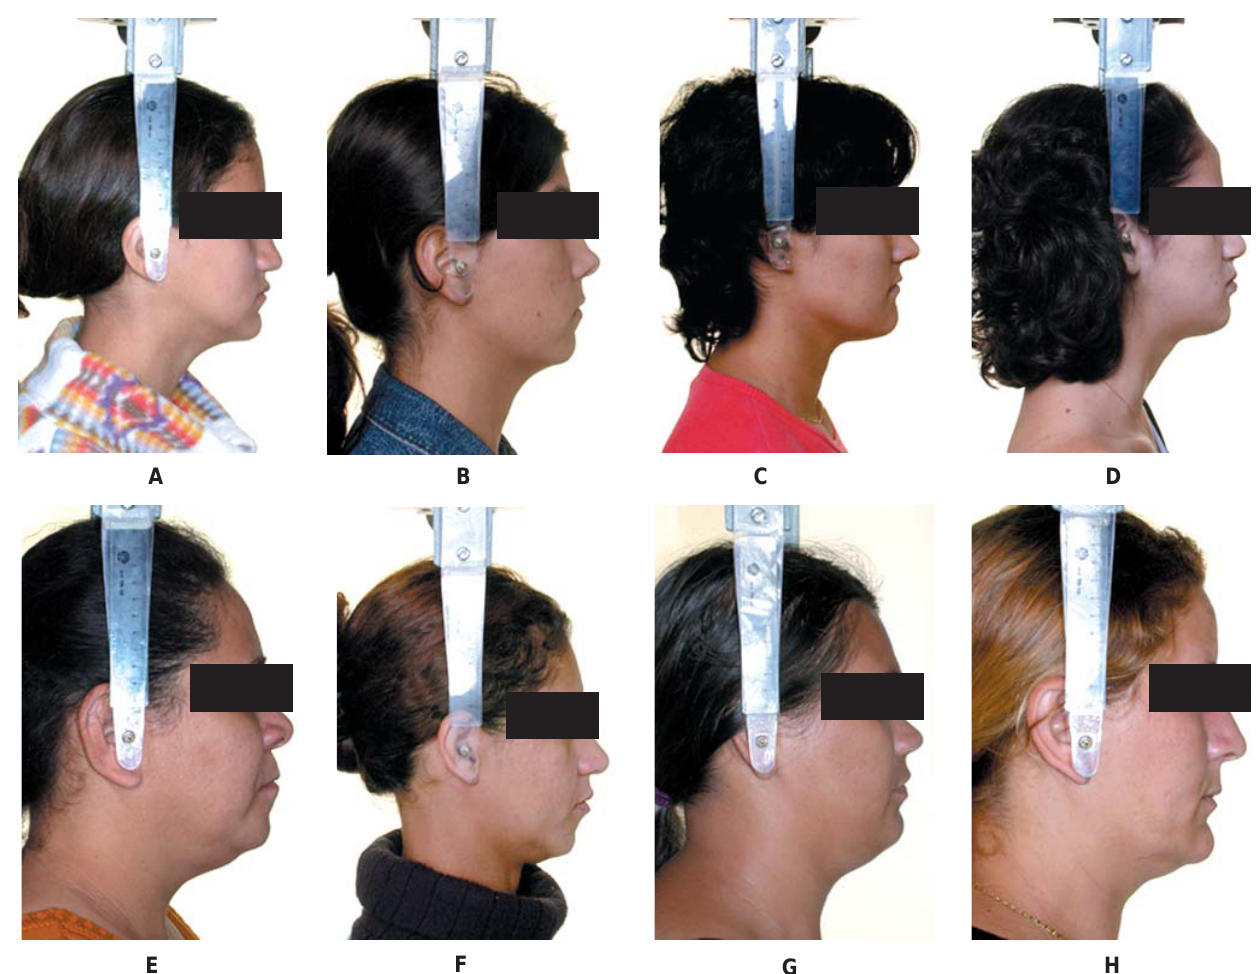
FIGURE 6- Patients selected from the sample of 85 patients with isolated cleft palate. A) to D) adult patients operated at conventional ages. E) to H) unoperated adult patients